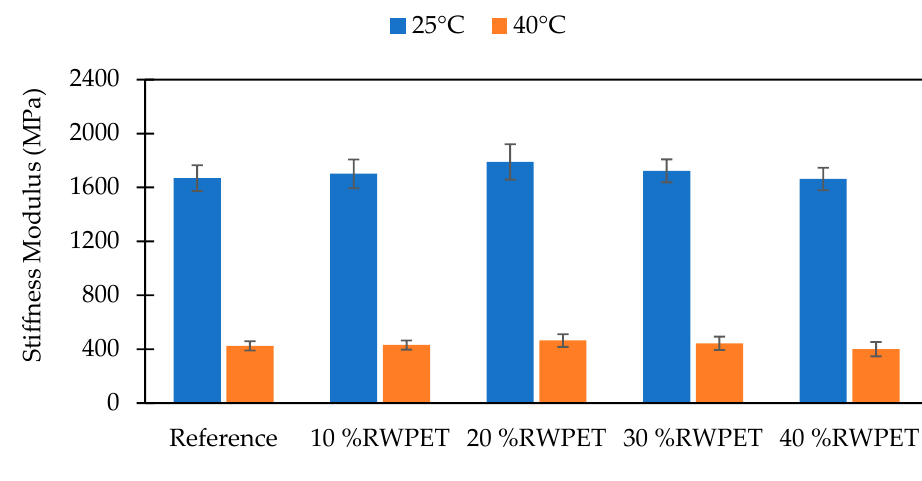
Figure 5. Effect of RWPET on stiffness modulus at 25 °C and 40 °C.